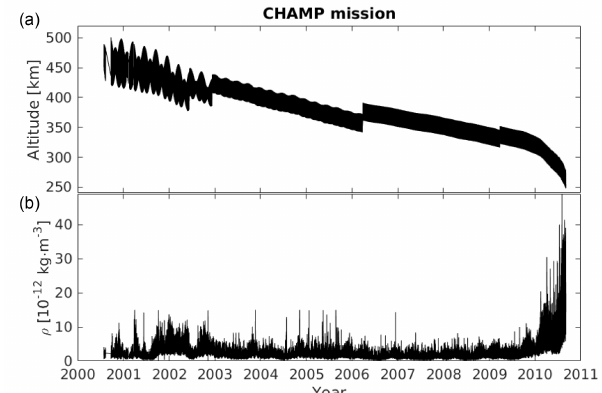
Figure 1. The satellite altitude (a) and thermospheric mass density (b) measured by the CHAMP satellite for the whole mission